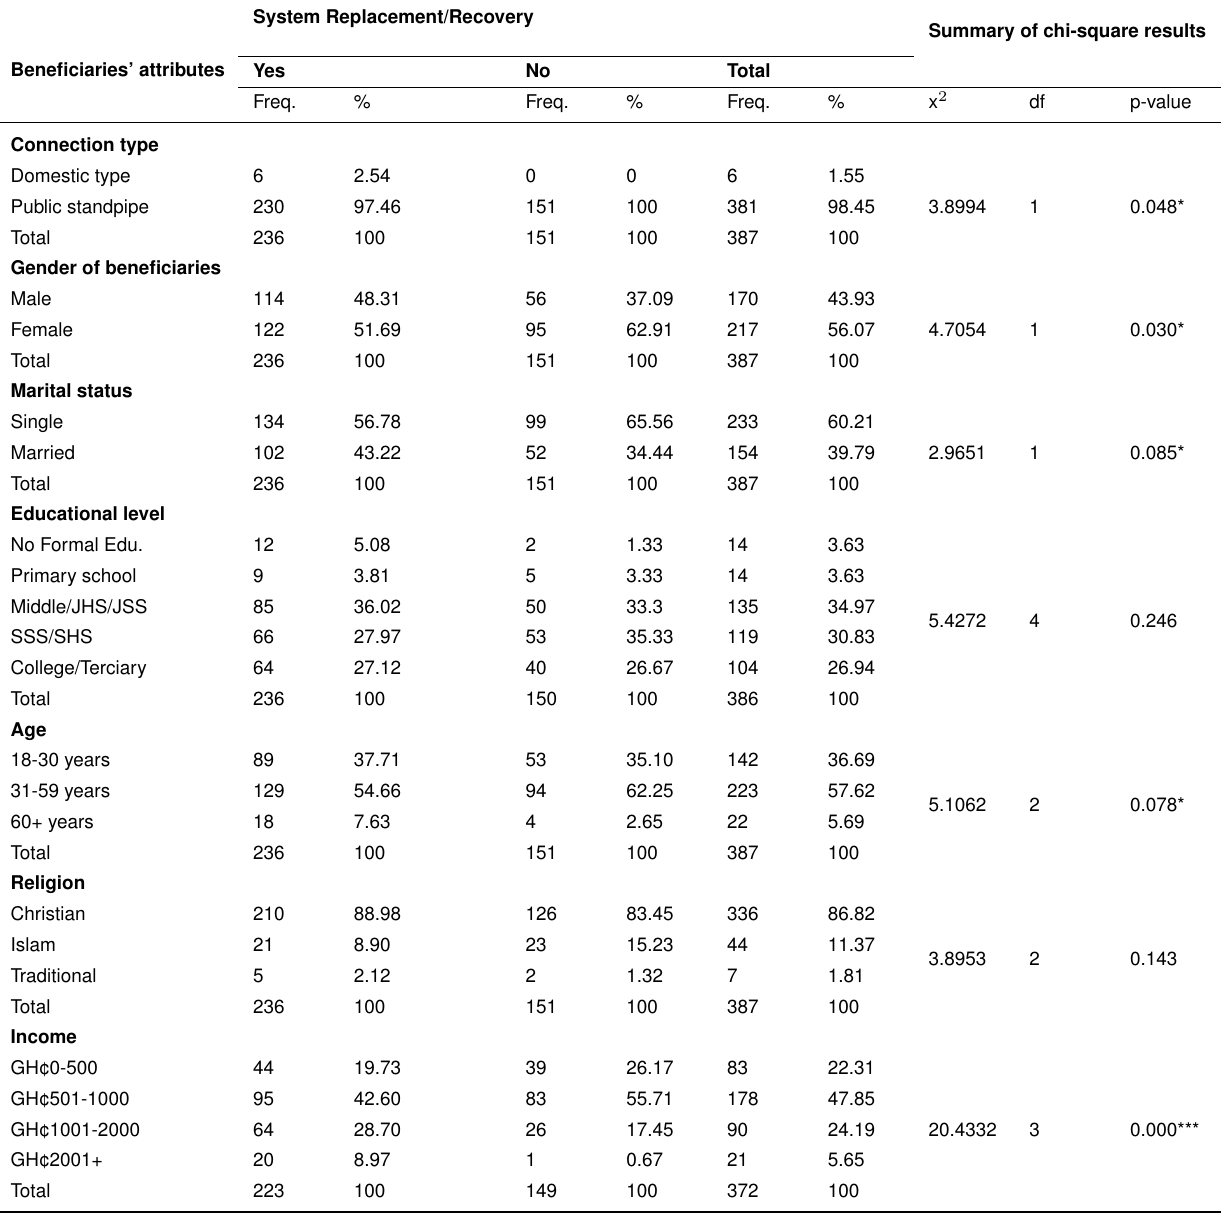
Table 4. Cross-tabulation of beneficiaries’ attributes and perception of